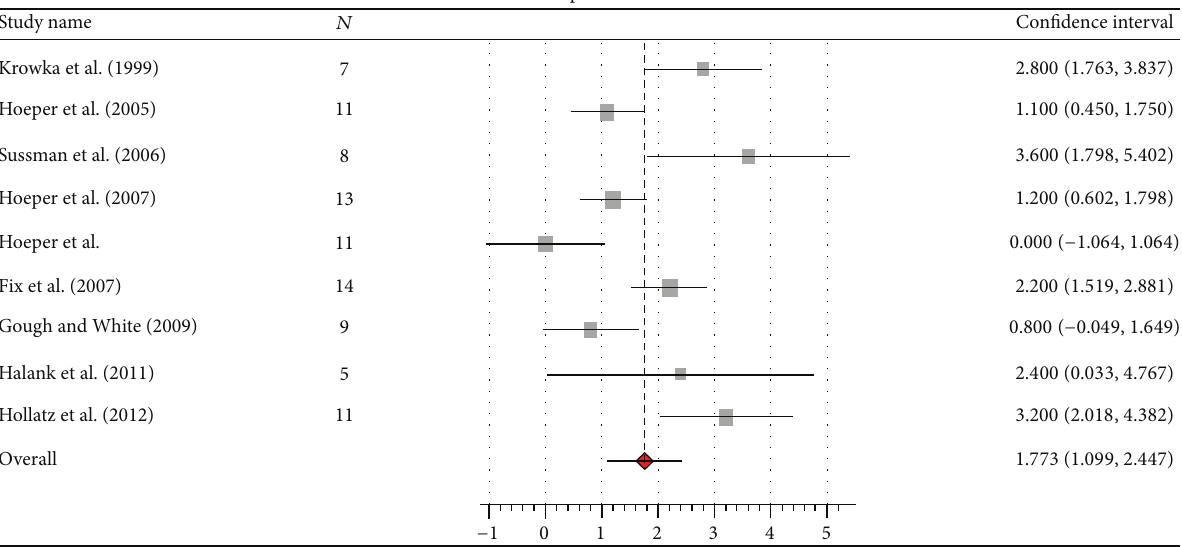
Figure 3: Effect of pulmonary arterial hypertension specific therapy on cardiac output